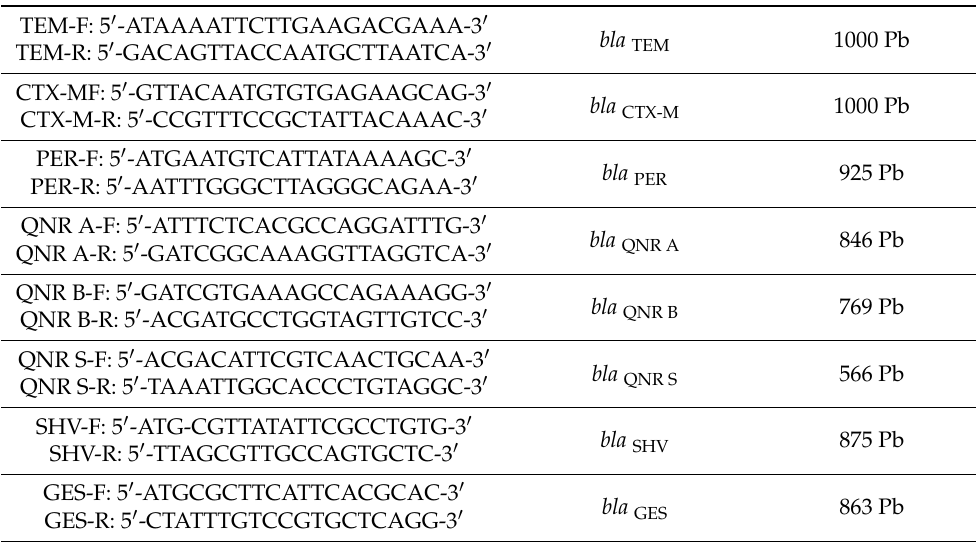
Table 1. Primers used and antibiotic resistance genes